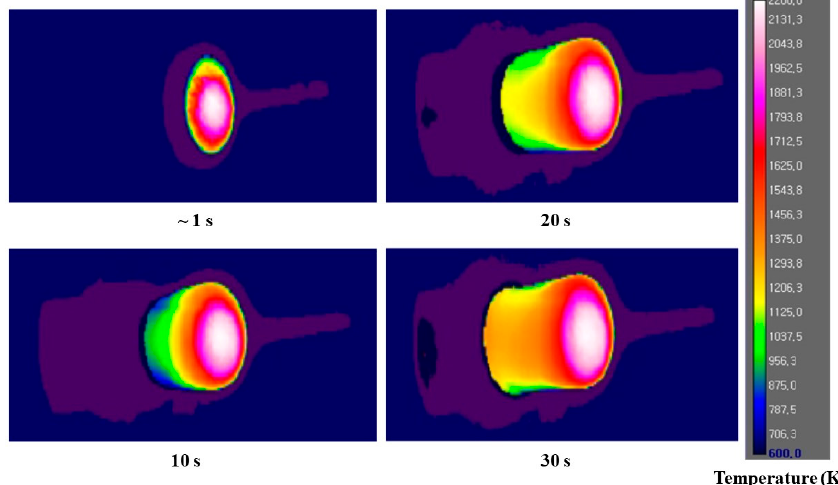
Figure 19. IR images of the CP (30°)-4 specimen.